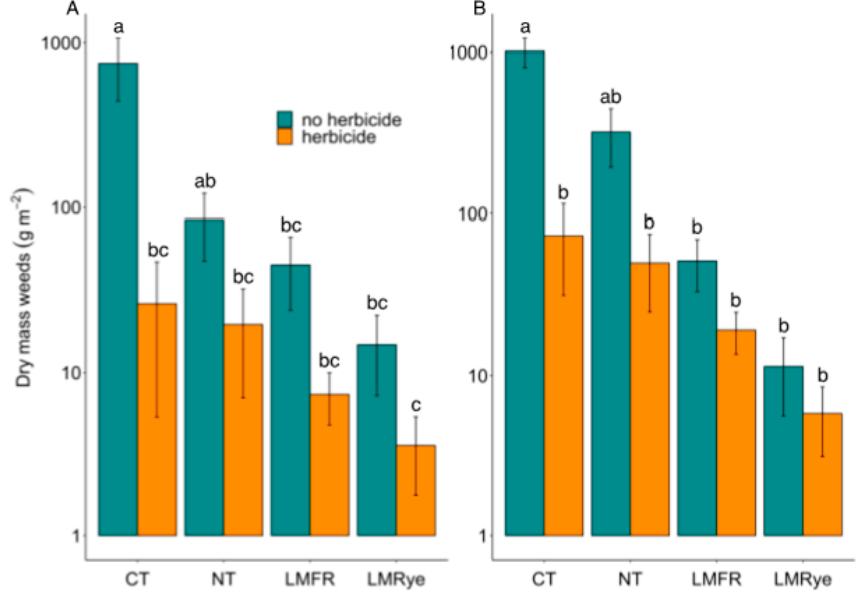
Figure 2. Weed biomass collected from unweeded areas ( A ) six weeks after sweet corn planting and ( B ) following crop harvest over three experimental years in conventional till (CT), no-till (NT), living mulch + forage radish residue (LMFR), and living mulch + rye residue (LMRye). Y axis presented on a log scale. Different letters indicate significant differences.